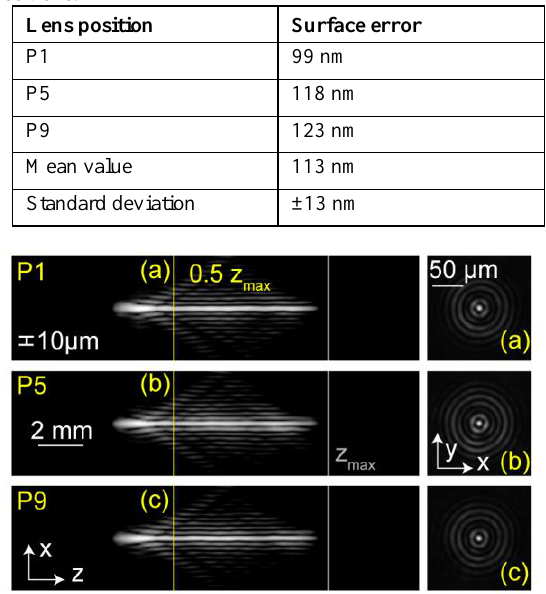
Fig. 4. Measured intensity profile of the Bessel beam (logarithmically scaled) for three different positions (left) with cross-sections at z max /2